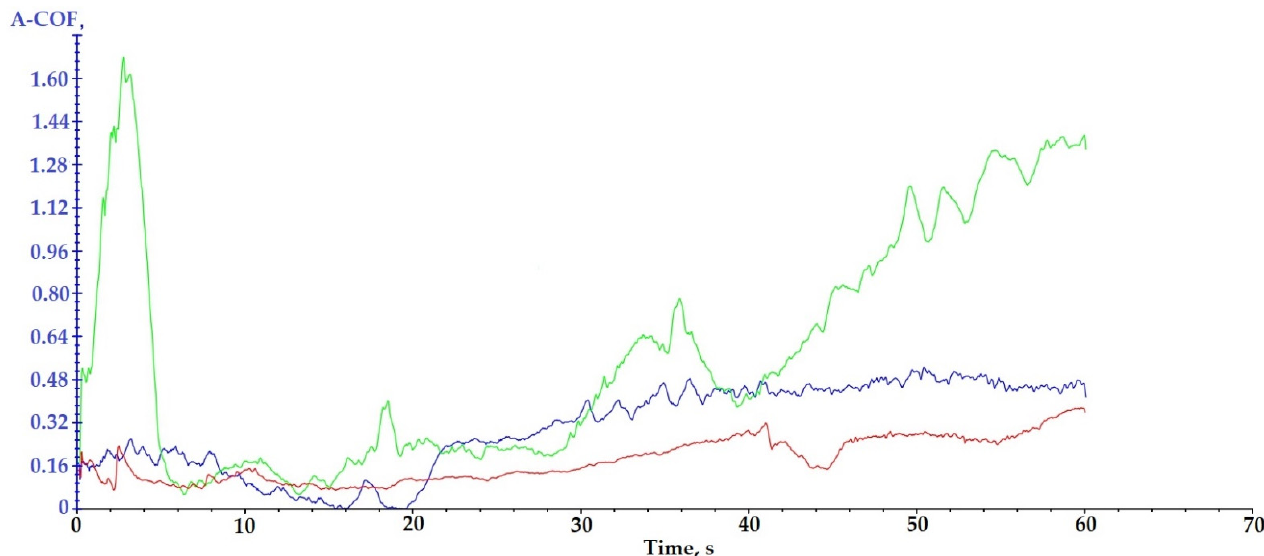
Figure 9. A-COF variation with test time for samples coated with ceramic micropowders: (blue) P3–143–9 passes; (green) P6–6420–9 passes; (red) P9–136–9